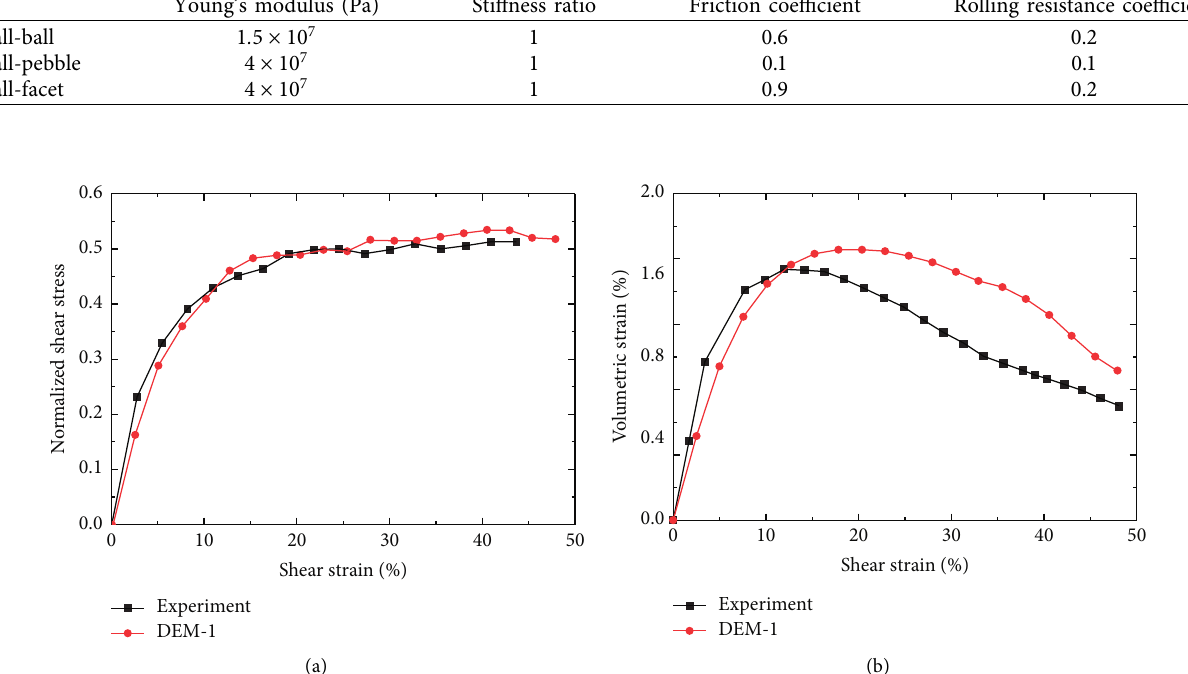
Figure 10: (a) Shear stress and shear strain relations. (b) Shear strain and volumetric strain